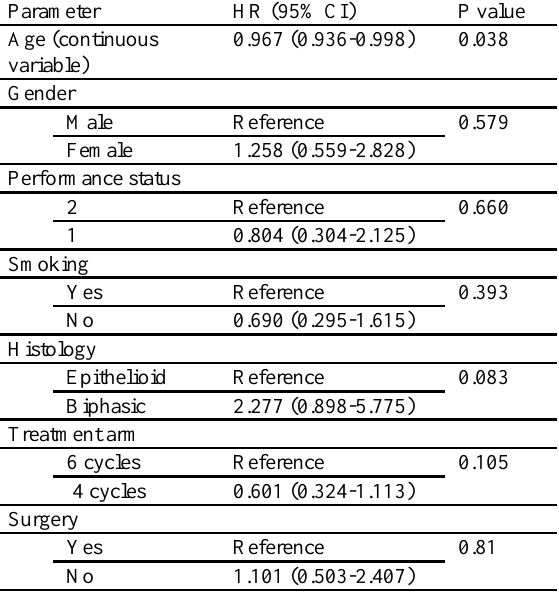
Table 2: Multivariate Cox regression analysis of factors affecting overall